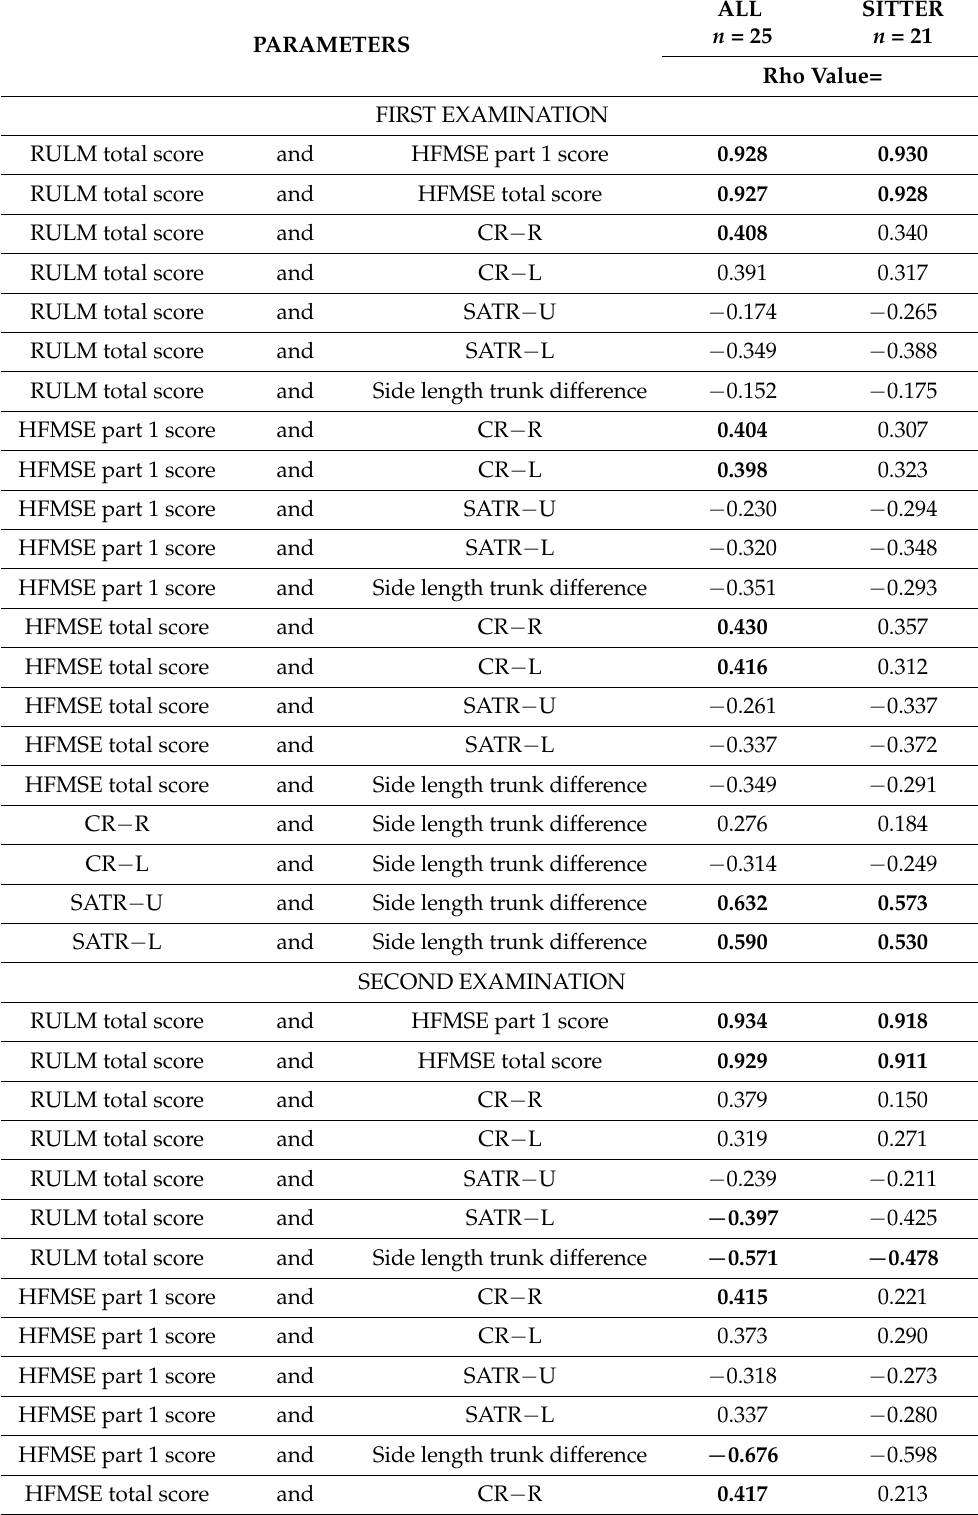
Table 5. The relationship (Spearman’s test correlation) between the measured parameters. Statistically significant values ( p < 0.05) are shown in